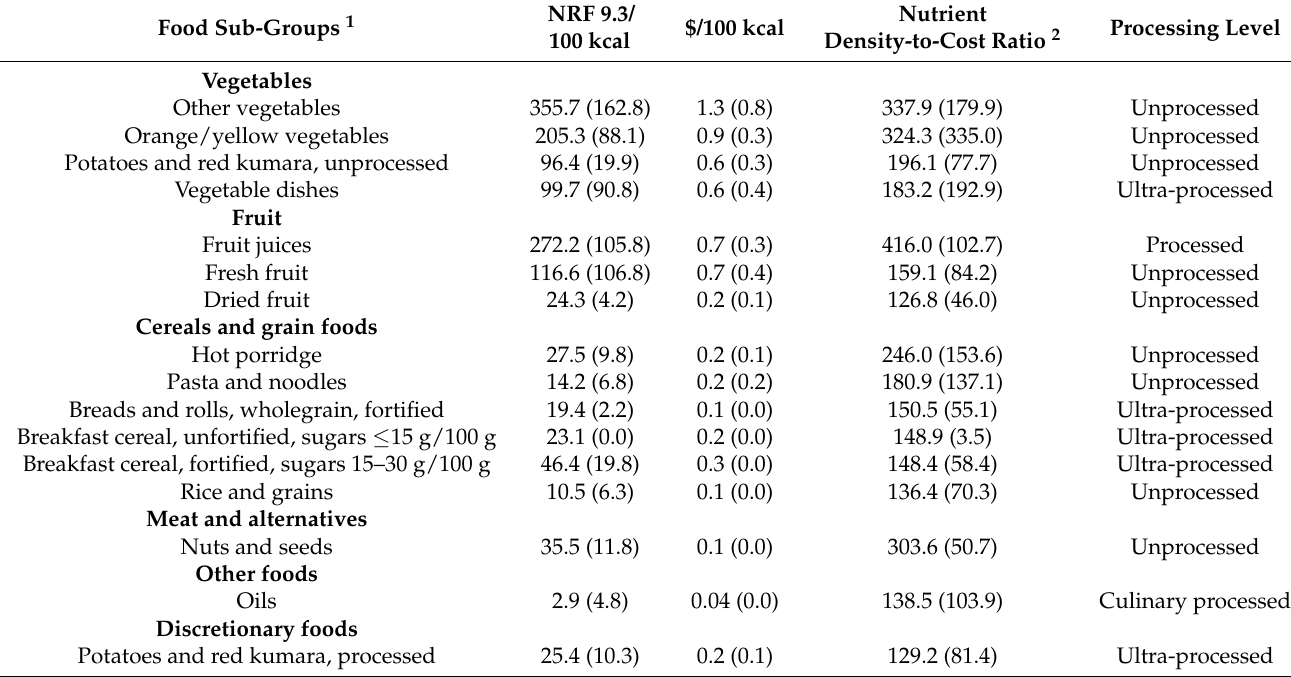
Table 2. The top quartile of nutrient dense, low-cost food categories. NRF 9.3/100 kcal, NZD/100 kcal, nutrient density-to- cost ratio, and NOVA processing level of each food category are